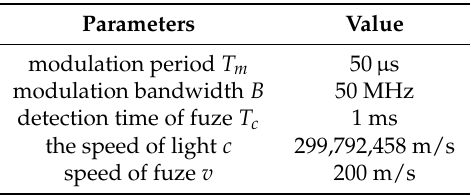
Table 1. Simulation parameters.